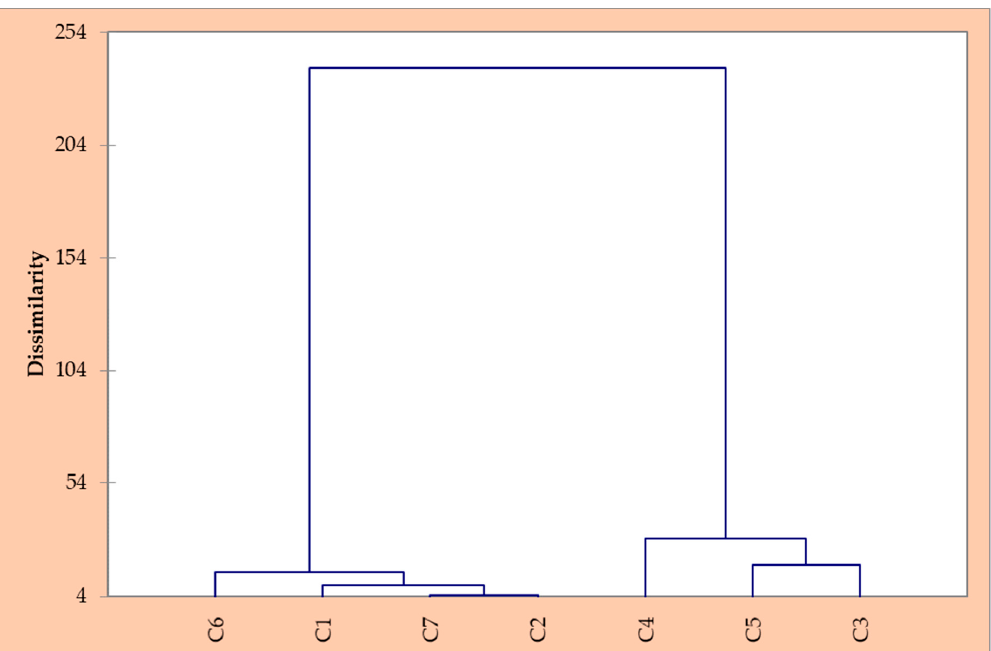
Figure 8. Dendrograms showing relationship among 84 accessions of the four wild Vigna species and three domesticated varieties regarding their weights before soaking, water absorption and cooking time.